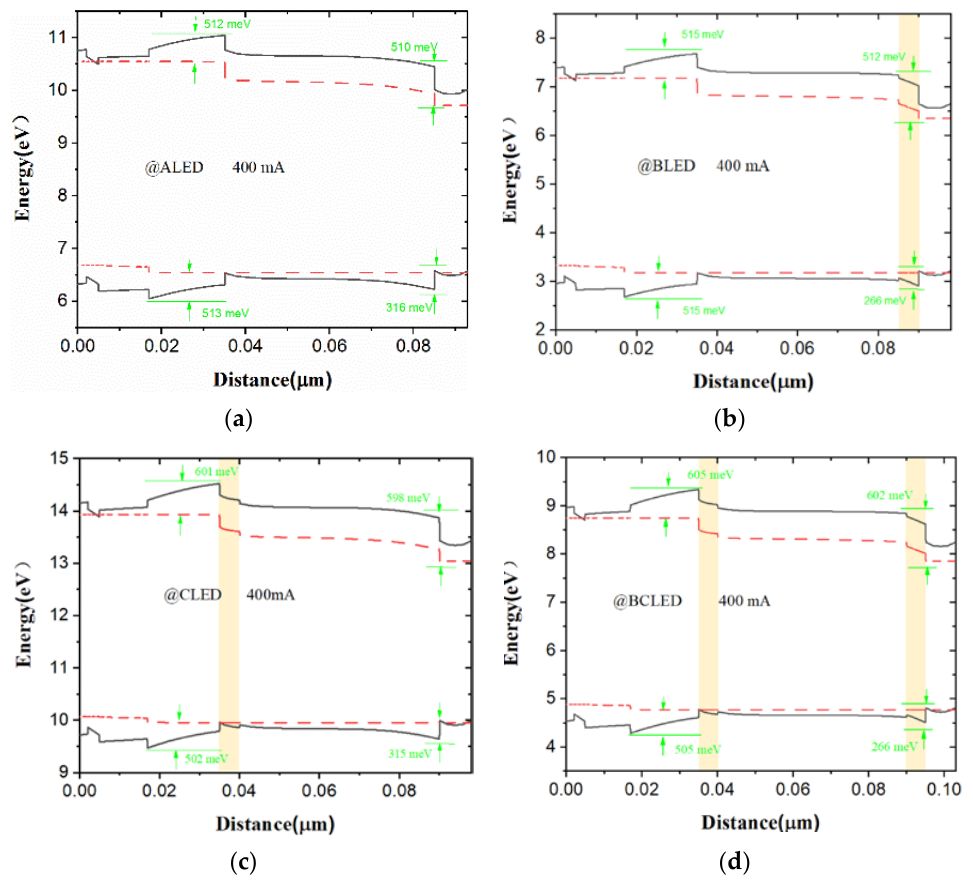
Figure 3. Energy band diagrams of ( a ) ALED, ( b ) BLED, ( c ) CLED, ( d ) BCLED at 400 mA respec- tively.